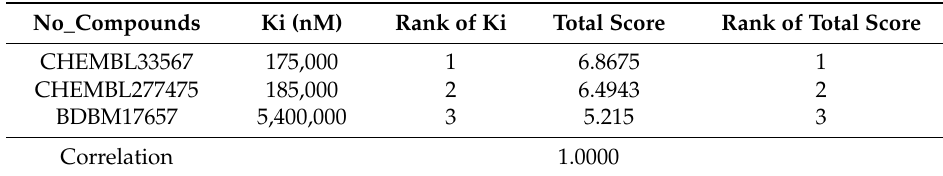
Table 6. The data of correlation between the rank of compounds experimental affinity (Ki) and docking score of mGluR7.